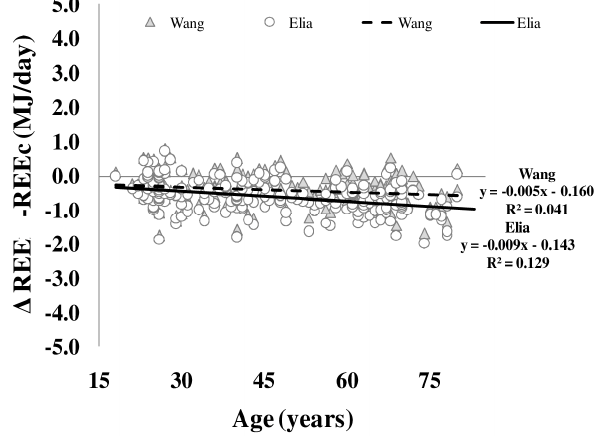
Figure 4. Age ‐ dependency of differences between measured and calculated resting energy expenditure (REE–REEc). REEc was calculated from organ/tissue masses (as assessed by whole body MRI times organ ‐ and tissue ‐ mass ‐ specific metabolic rates as published by Elia ( circles ) and Wang ( triangles , i.e. , using age ‐ adjusted specific metabolic rates) ( n = 217) (for details, see Methods).